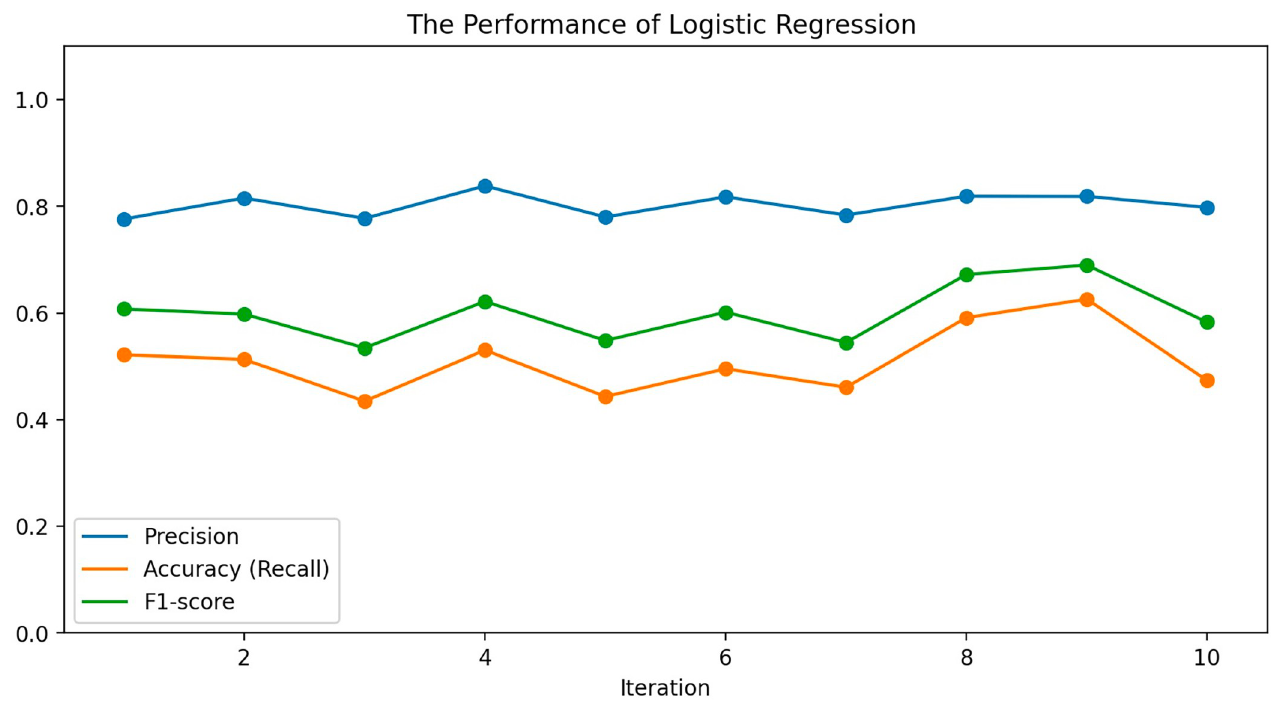
Fig 7. The performance of logistic regression